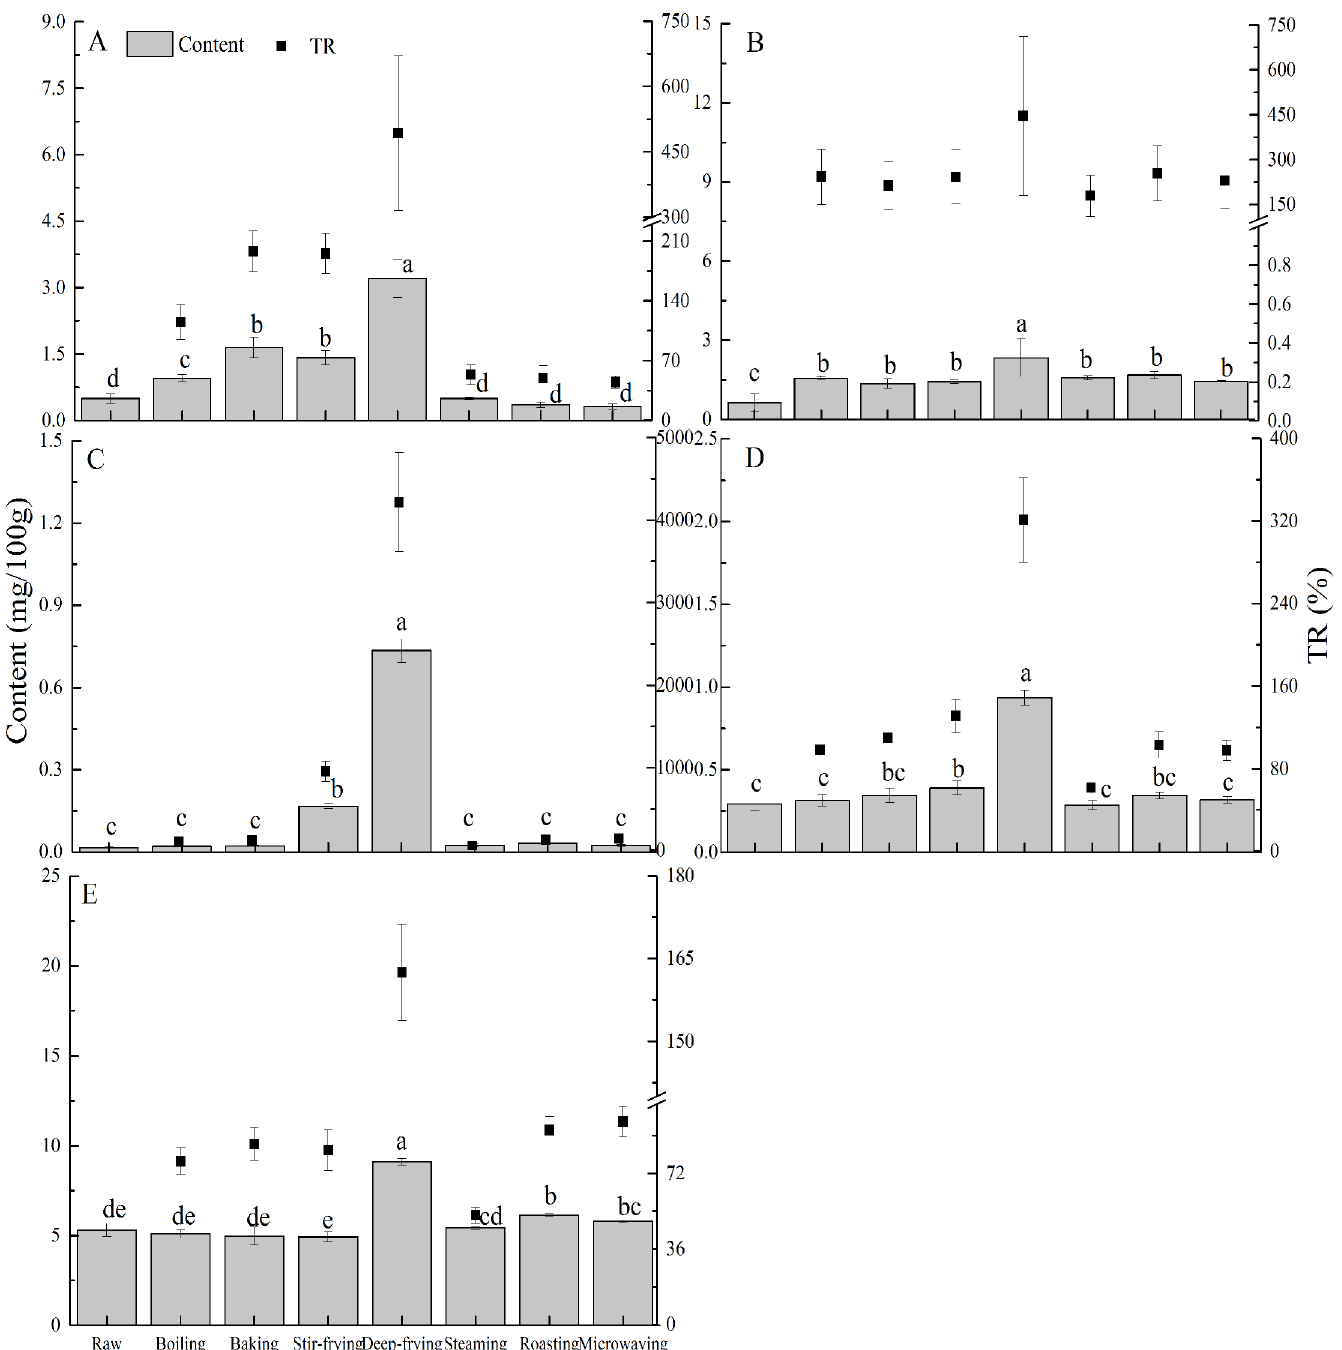
Fig 4. The content of α -tocopherol (histogram) and related true retention (TR) ( ■ ) for crown daisy (A), unripehot pepper(B), onion (C), garlic (D) and red pepper(E). Values are mean ± SD of three measurements. Bars of histograms ( α -tocopherolcontent) with same letters are not significantly different (p >